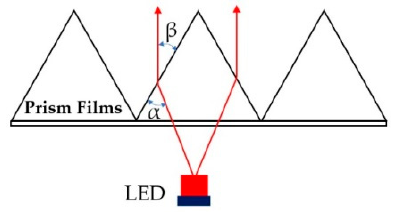
Figure 4. The interaction of light rays with the prism sheet.